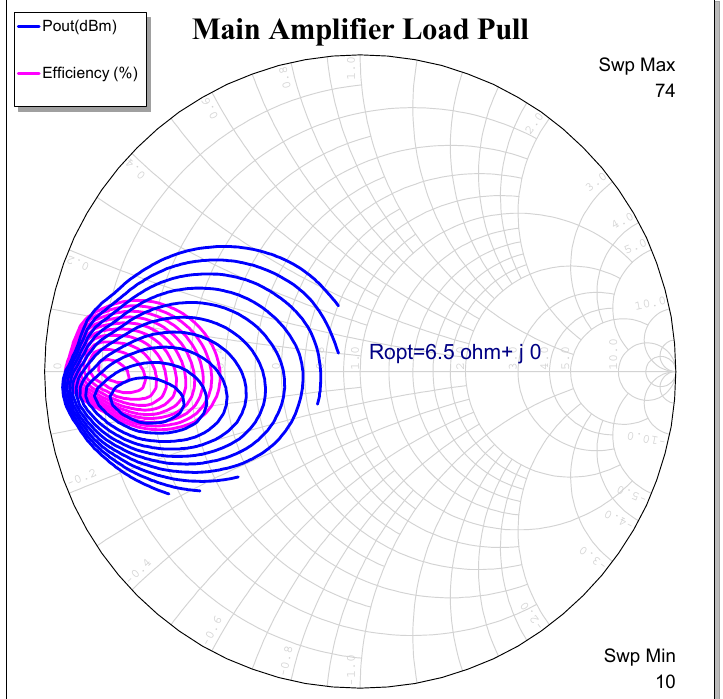
Figure 4. Main amplifier load-pull contours.